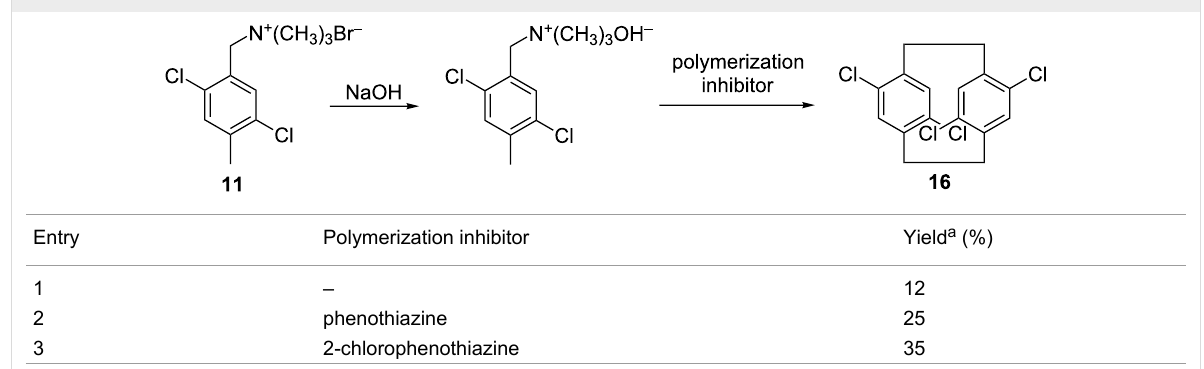
Table 3: Synthesis of 4,7,12,15-tetrachloro[2.2]paracyclophane 16 from 11